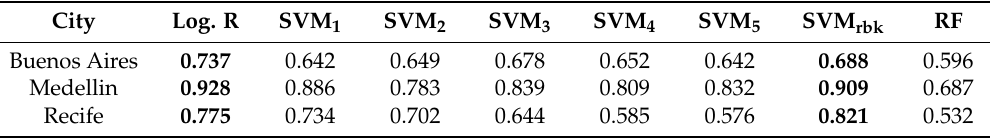
Table 5. Individual Model for Slum Detection ( F2